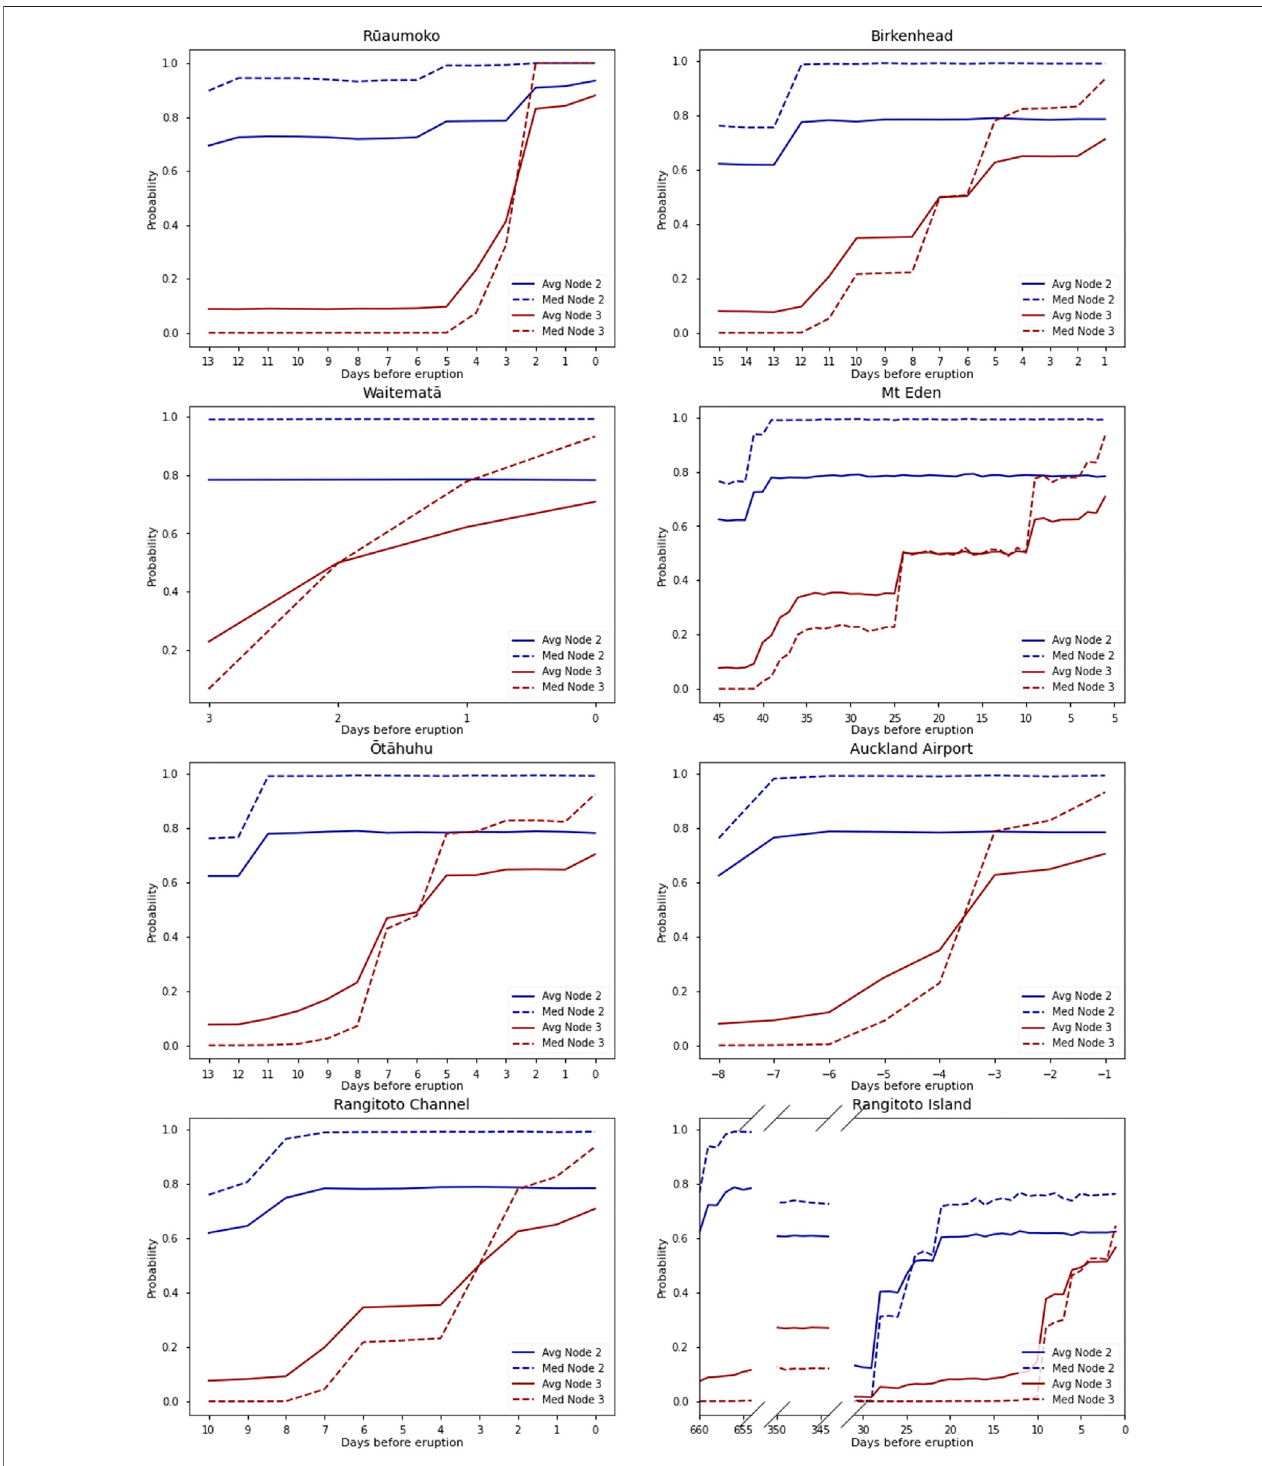
FIGURE 6 | Time evolution of BETEF_AVF output probabilities for magmatic unrest and eruption forecasting for each of the eight AVF eruption scenarios. This application uses the distributions a = U (0.75, 1) and b = U (0, 2).